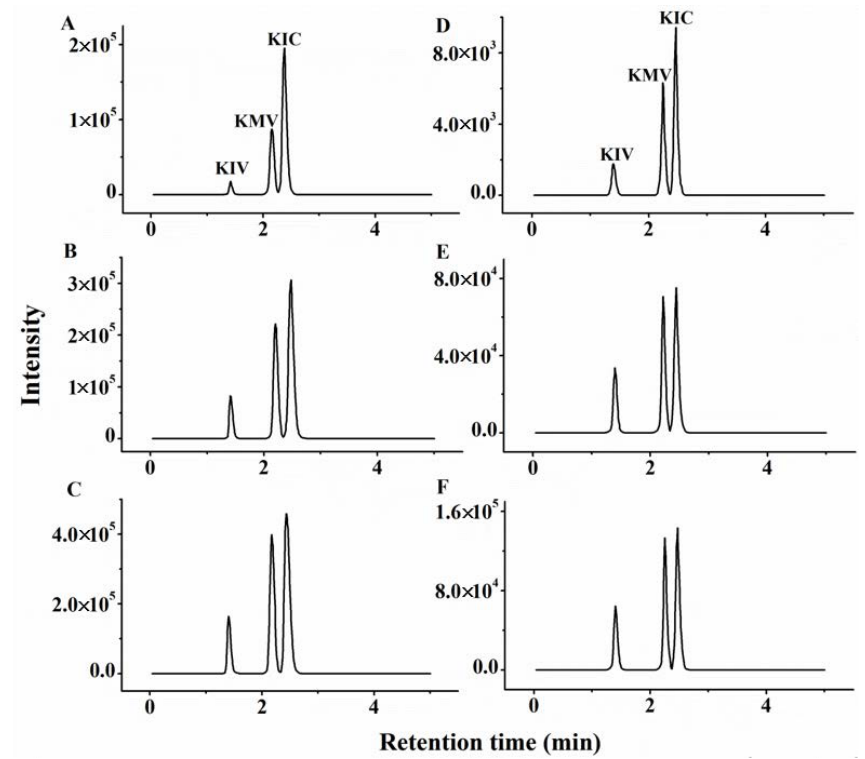
Figure 5. Representative chromatograms of BCKAs in different samples. ( A ) No-spike serum sample, ( B ) Low-spike serum sample, ( C ) High-spike serum sample, ( D ) No-spike muscle sample, ( E ) Low-spike muscle sample, ( F ) High-spike muscle sample.